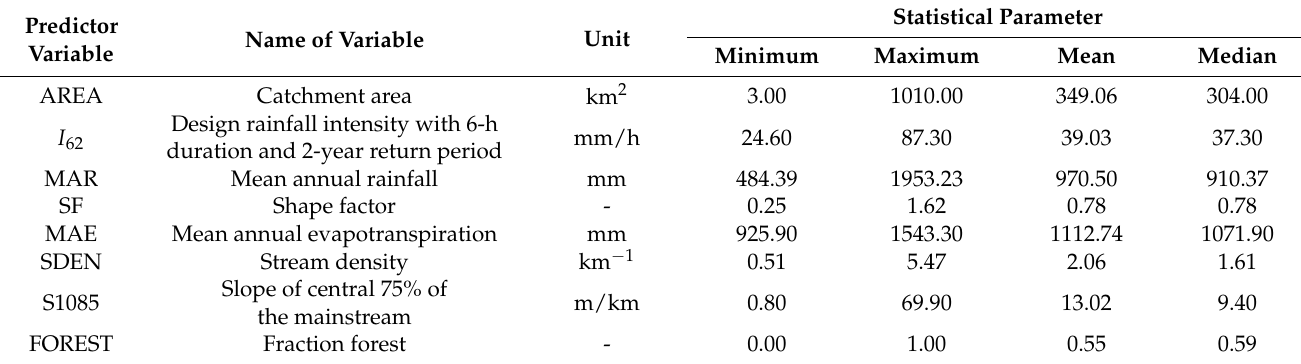
Table 1. Summary of the candidate predictor variables based on 181 study